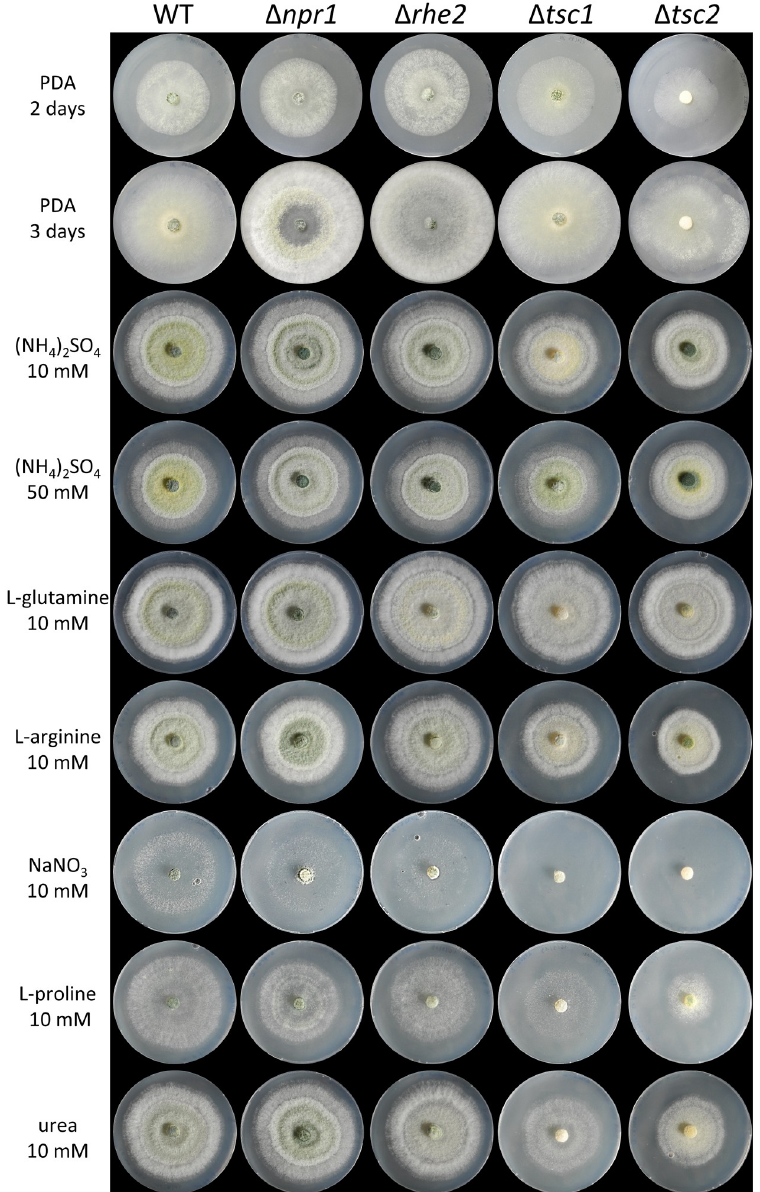
Fig 3. Effect of npr1 , rhe2 , tsc1 and tsc2 gene deletion on mycelial growth of T . atroviride on different nitrogen sources. Fungi were grown on PDA or on minimal medium amended with different nitrogen sources (10 or 50 mM ammonium sulfate, 10 mM L-glutamine, 10 mM L-arginine, 10 mM sodium nitrate, 10 mM L-proline, or 10 mM urea) at 25˚C for three days. Growth on PDA after two and three days is